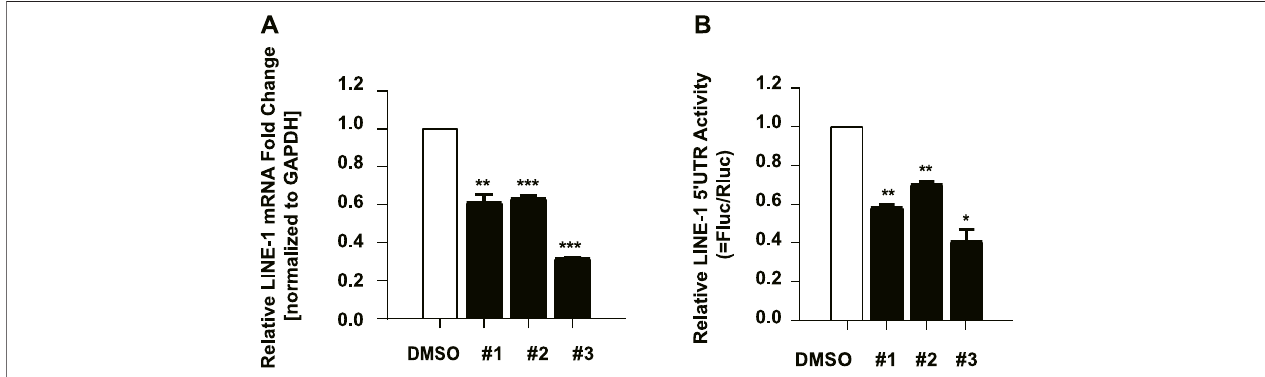
FIGURE 5 | The effect of the compounds on LINE-1 RNA synthesis. (A) , The effect of the compounds on the LINE-1 RNA level in T-47D cells. T-47D cells were treated with #1, #2 and #3 (10 μ M) respectively, and 48 h later, the LINE-1 mRNA level was quanti fi ed using RT-qPCR. (B) , 293 T cells were transfected with L1-FL plasmid, and then treated with the indicated compound. The fi re fl y luciferase activity driven by the LINE-1 5 ′ -UTR promoter was measured. pGL3-basic which contains the fi re fl yluciferasegenethatlacksapromoteratits5 ′ endservesasacontrolvector.Fire fl yluciferaseactivity inthepGL3-basictransfectedcellswasmeasured to re fl ect the basal expression of the fi re fl y luciferase gene. Data represent the mean ± SD of three independent experiments. p -values were calculated using a standard Student ’ s t-test. * p < 0.05, ** p < 0.01, *** p <